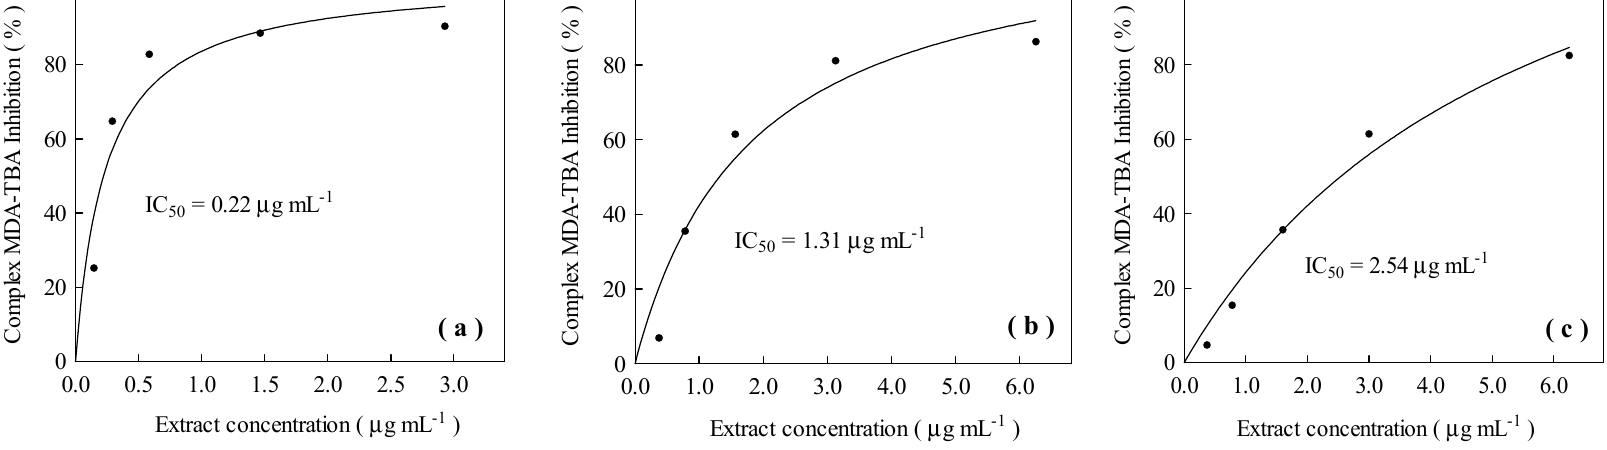
Figure 5. Experimental results of the inhibition of the lipid peroxidation induced by Fe +2 /citrate promoted by the concentrated extract ( a ), spouted bed dried extract ( b ), and lyophilized extract ( c ).